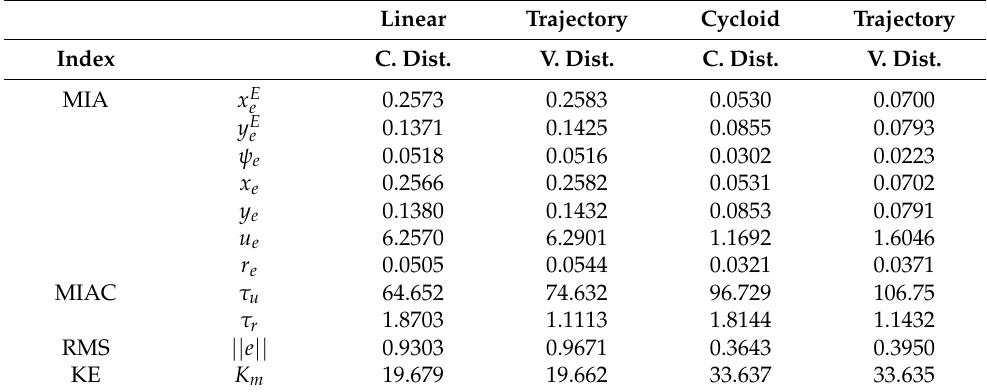
Table 3. Performance for